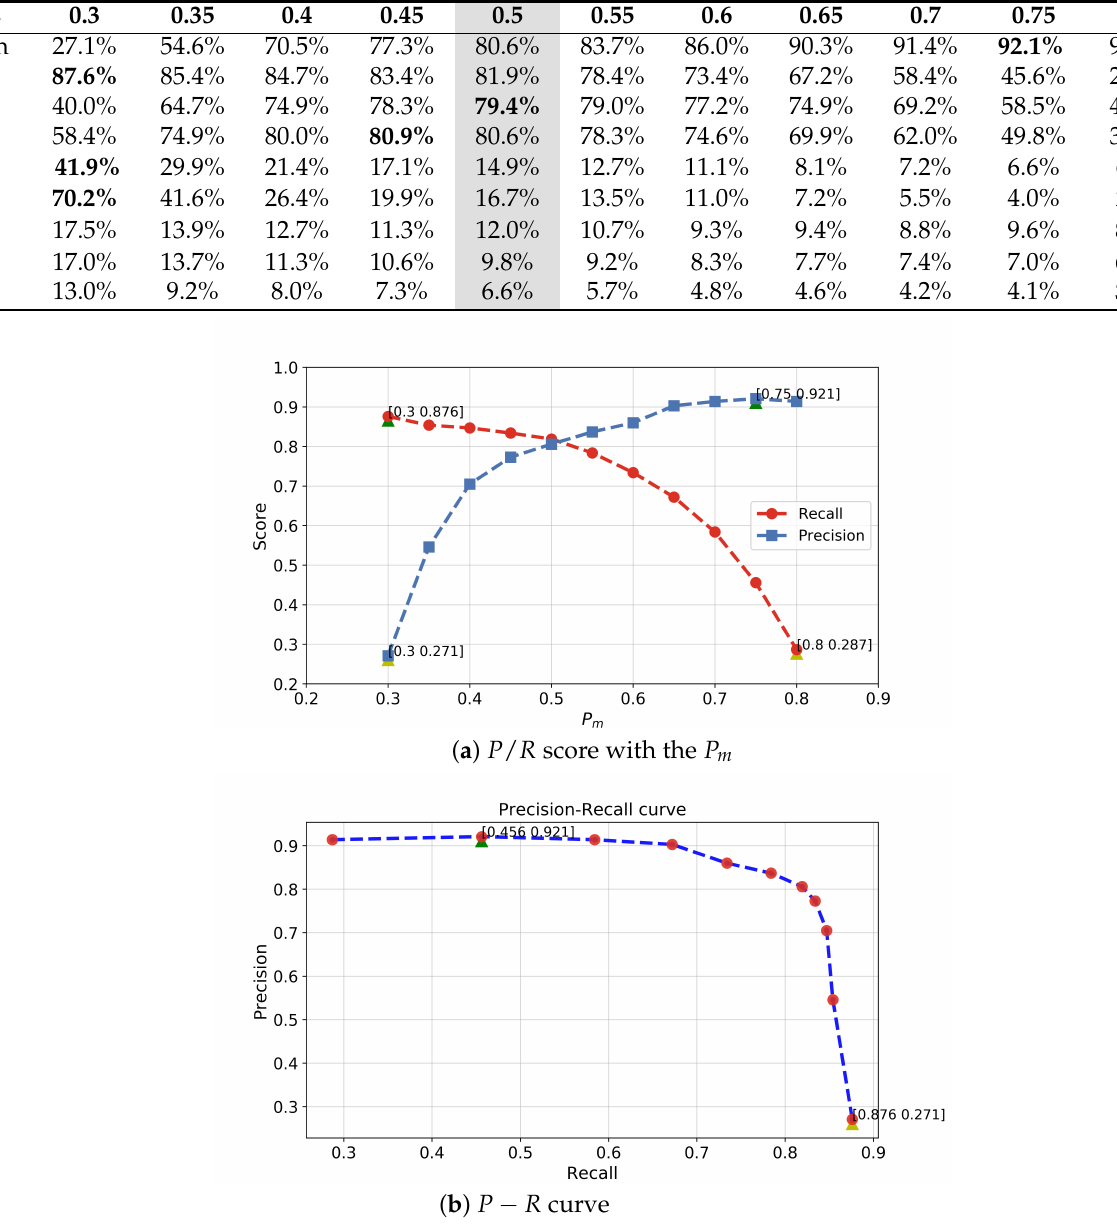
Figure 11. Precision/recall curve for the crater detection